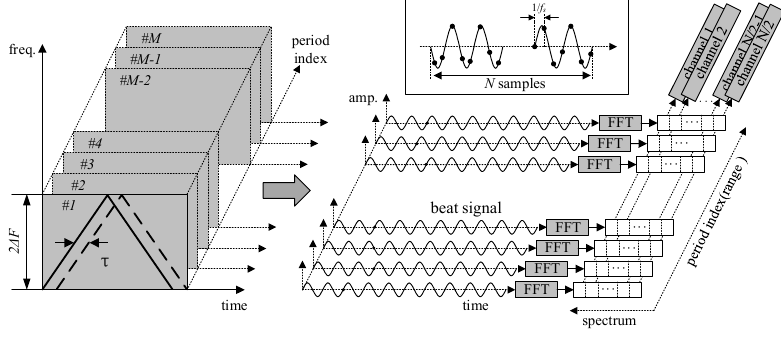
Figure 5. Basic concept of FFT-based harmonic timing sequence detection.